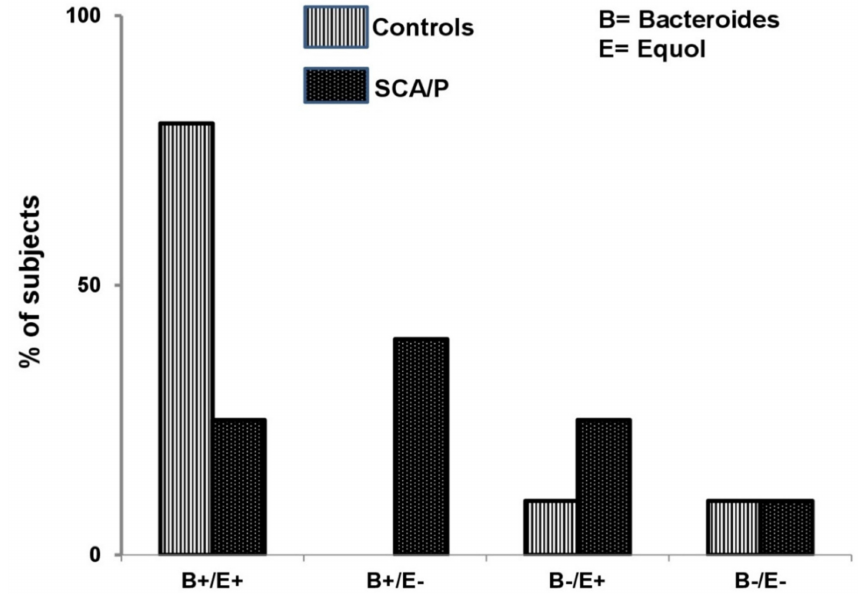
Figure 5. Fecal Bacteroides strains and urinary equol